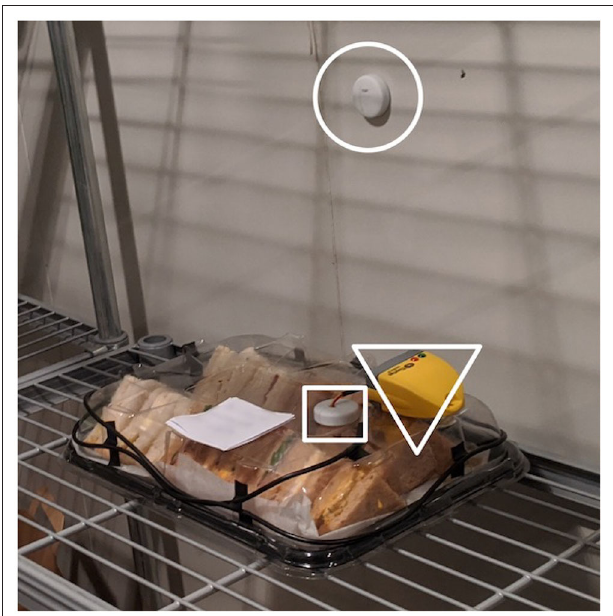
FIGURE 13 | A sandwich box used in the trials with the university catering services. The fridge beacon is highlighted with a circle, the IoT monitor with a square, and the certified temperature logger with a